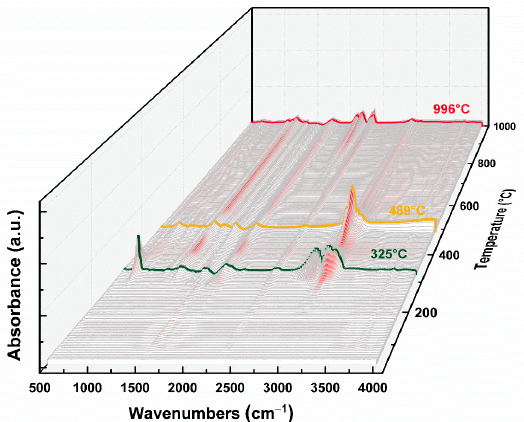
Figure 3. Ion current of evolved gaseous products during pyrolysis of PET film. Table 3. Composition table of the evolved gaseous products during pyrolysis of PET film.